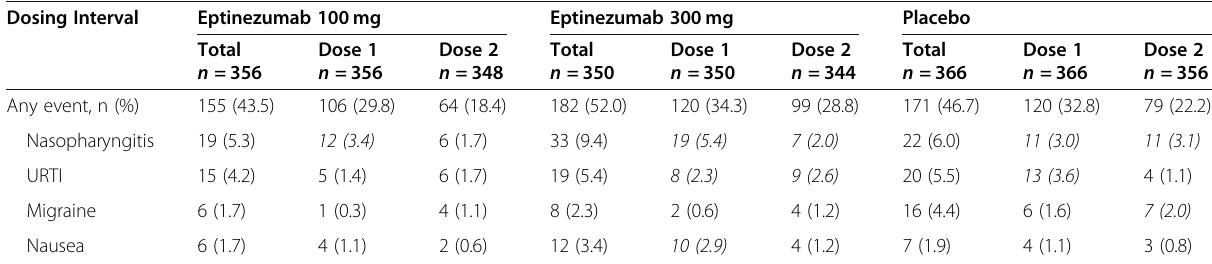
Table 2 Treatment-emergent adverse events reported in ≥ 2% of patients in any treatment group by dosing interval (safety population) Dosing